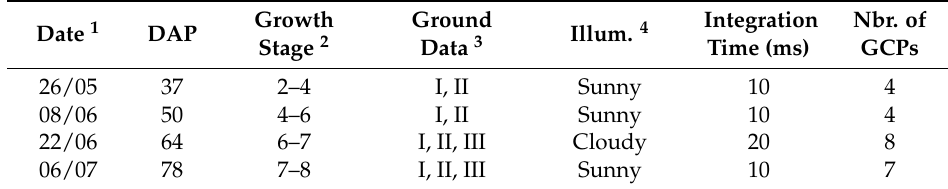
Table 1. General aspects related to the data acquisition using the Unmanned Aerial Vehicle (UAV) platform and a ground-based sensing setup (Section 2.3). Days after planting (DAP), estimate general crop growth stage according to the BBCH (‘Biologische Bundesanstalt, Bundessortenamt and CHemical industry’) scale [50], illumination conditions, and number (nbr.) of ground control points (GCPs) used during photogrammetric